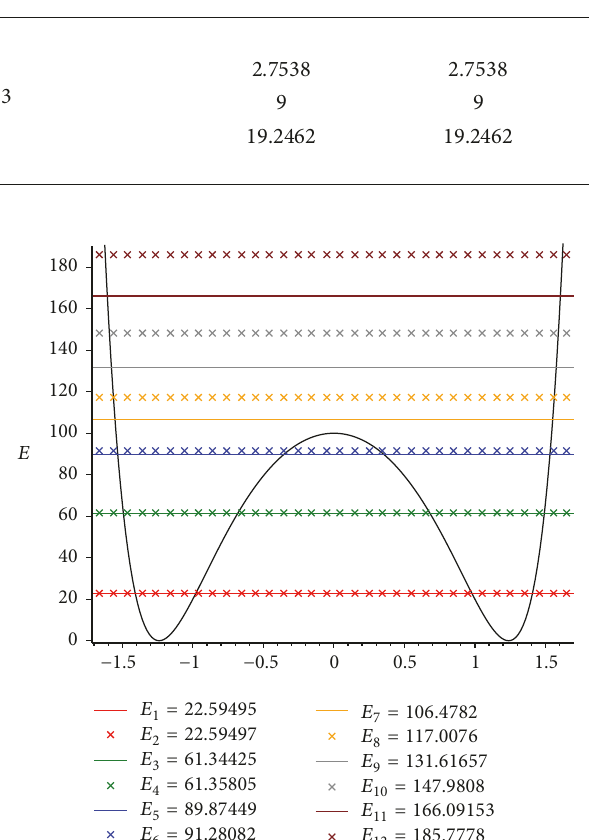
Figure 2: The Razavy bistable potential and the energy levels splitting with 𝜉 = 2 and 𝑀 = 12